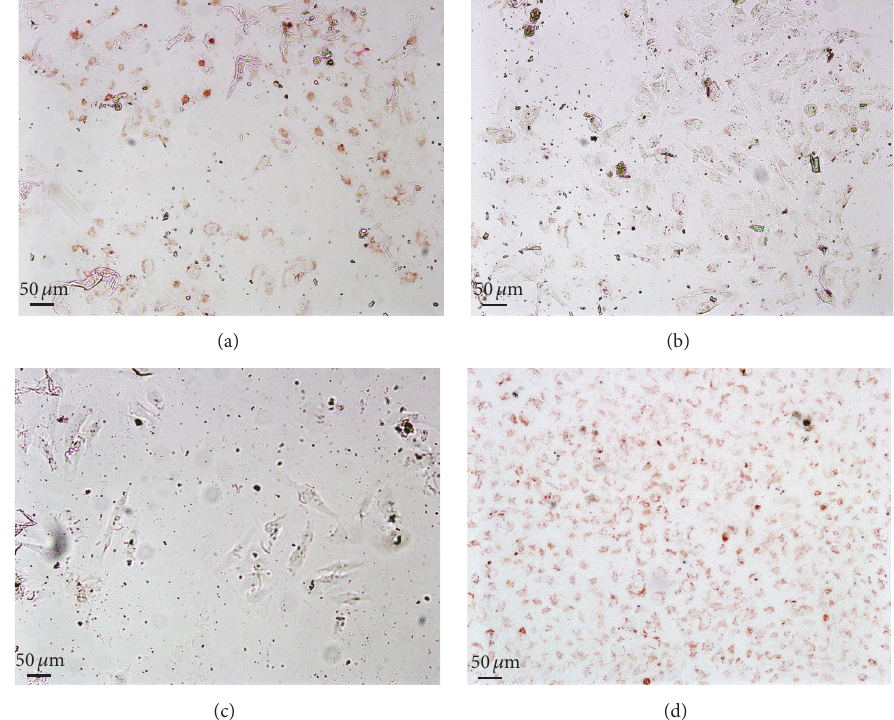
Figure 6: Effects of HTST-juice on HeLa measured as NRU; red stained cells indicate metabolic activity (magnification: 100x): 60 𝜇 L/mL (a), 100 𝜇 L/mL (b), 300 𝜇 L/mL (c), and HTST-juice and 50 𝜇 g/mL aloin